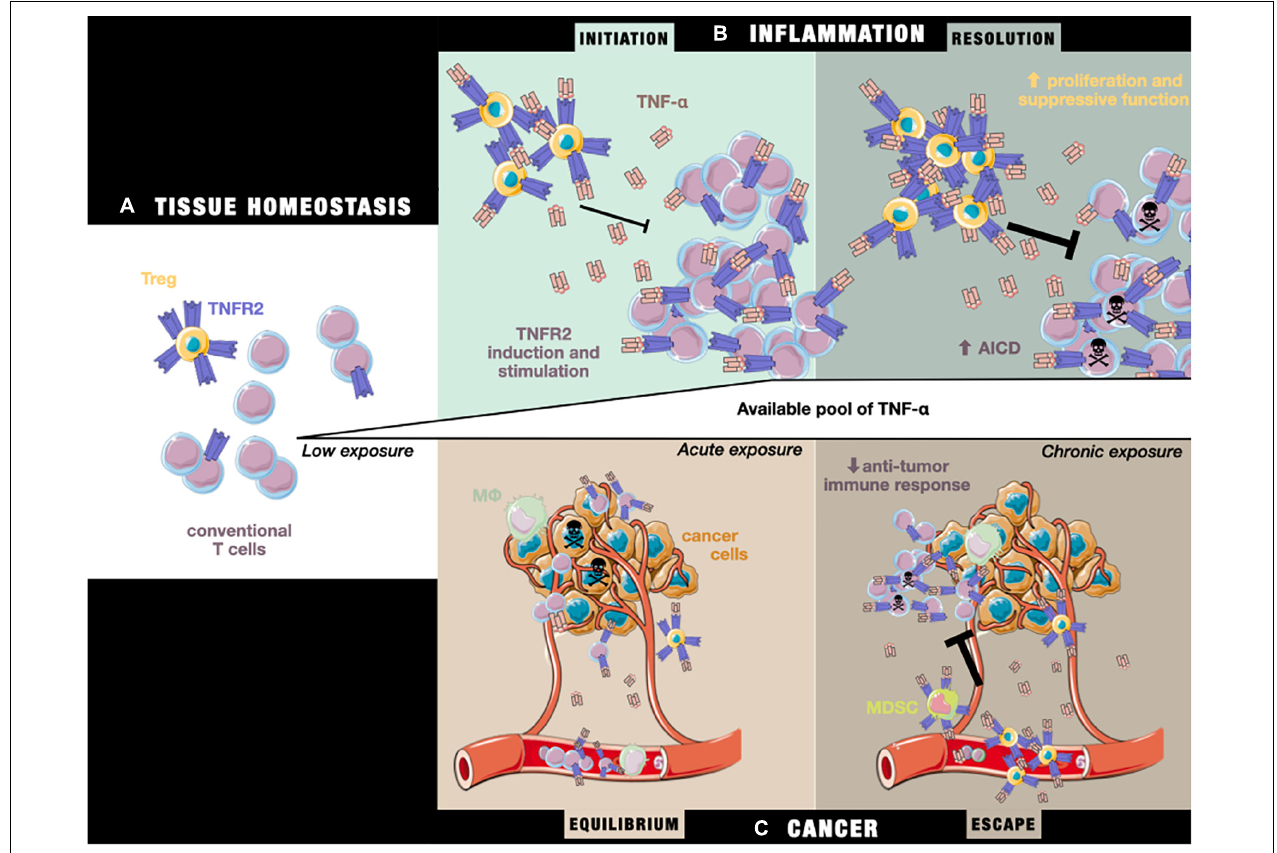
FIGURE 2 | The impact of TNF- α /TNFRs on the T cell equilibrium during (A) tissue homeostasis, (B) the initiation and resolution of inflammation, and (C) cancer equilibrium and escape. (A) In the steady state, TNFR2 is more highly expressed by Tregs than Teffs. (B) Under inflammatory conditions, exposure to initiation-phase cytokines (including TNF- α ) induces higher expression of TNFR2 on T cells and co-stimulation signaling, aiding the T cell response. Tregs are unable to fully repress the Teff response. Later, during the resolution phase, chronic exposure to TNF- α sensitizes Teffs to cell death through TNFR2 activation, while Tregs are able to more potently inhibit Teffs by the stabilization and stimulation of their suppressive functions, leading to restoration of the steady state situation described in panel (A) . (C) During tumor growth, tumor cells and the TME produce TNF- α , leading to a T cell response against tumor cells by peripheral Teffs that have been attracted to the tumor site. In a state of equilibrium, this allows the elimination of a pool of cancer cells, while others more resistant to the immune response continue to proliferate. Over time, the TME evolves and attracts an increasing number of immunosuppressive TNFR2 + cells (including Tregs and MDSCs), leading to suppression of the anti-tumor response, while the chronic exposure of Teffs to TNF- α drives them toward AICD, unleashing tumor growth and allowing tumor cells to escape from immune